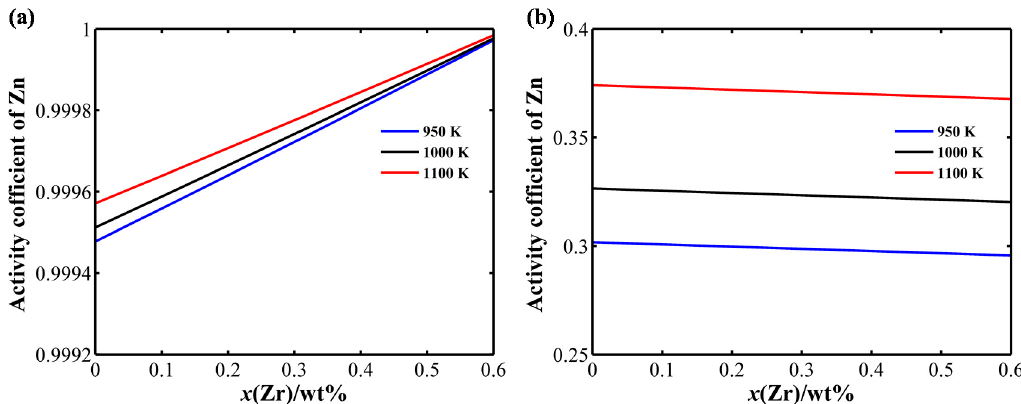
Figure 6. Effect of Zr addition on the activity coefficients of Mg and Zn in Mg-6Zn- x Zr melts at different